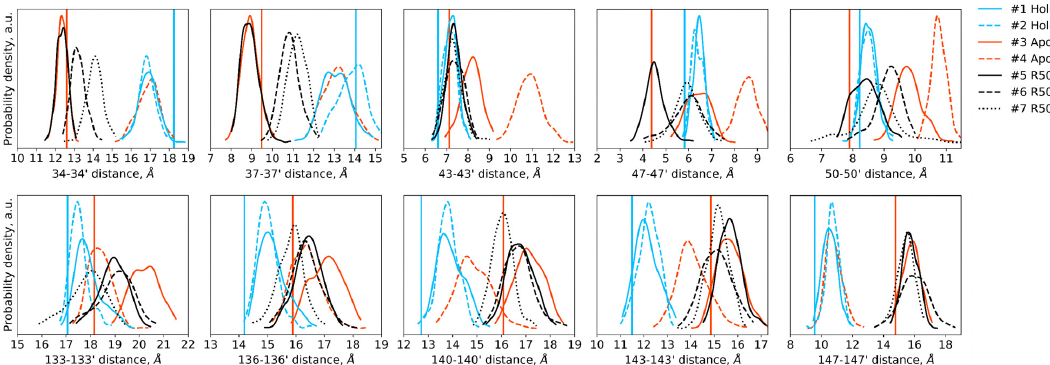
Figure 5. Distances between the backbone C α atoms of the designated residues within the dimer in the last 200 ns of the simulations. Distances between the residues 34–50 of the two protomers are indicative of TM1-TM1 ′ and H1-H1 ′ distances, whereas distances between the residues 133–147 are indicative of H4-H4 ′ and TM2-TM2 ′ distances. Vertical lines show the respective distances in the crystallographic structures: the values for the symmetric ligand-bound WT structure (PDB ID 5IJI) are shown in cyan, the values for the symmetric ligand-free WT structure (PDB ID 5JEQ) are shown in orange.